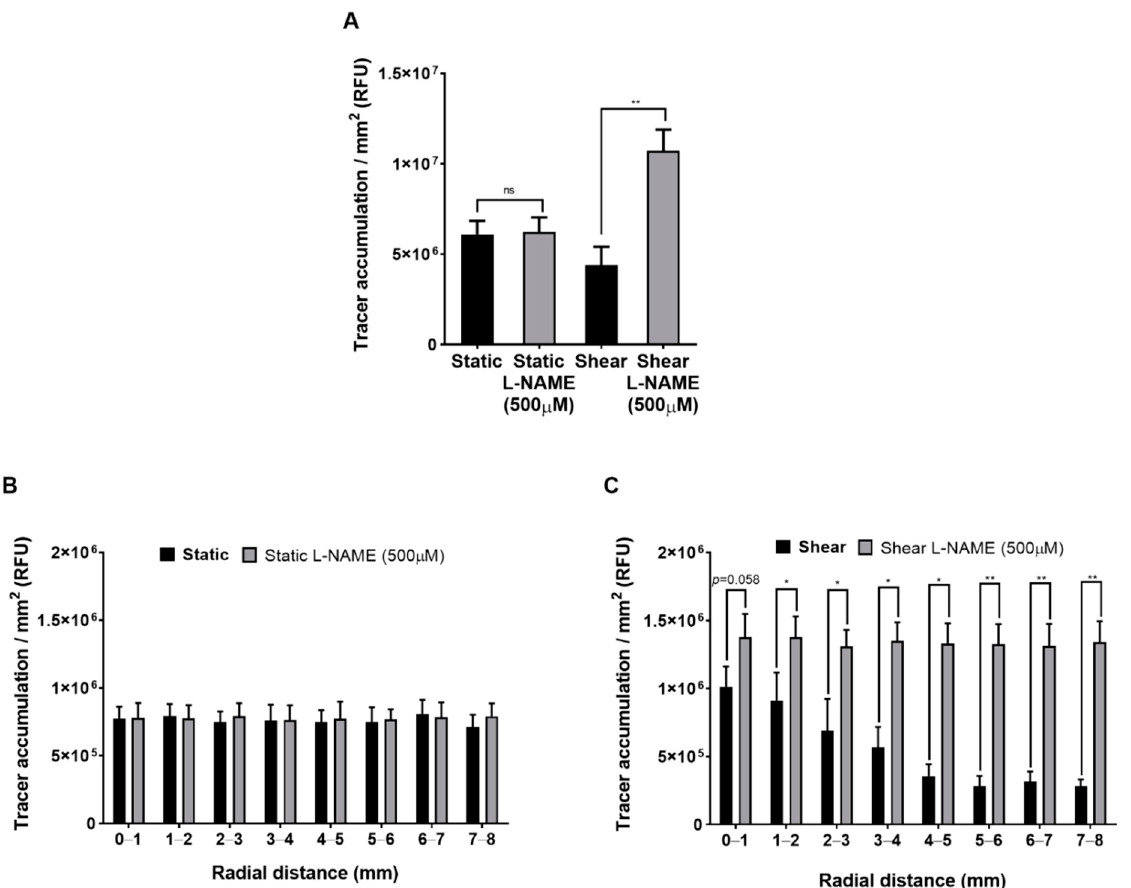
Figure 7. FITC-avidin accumulation averaged across the well for ( A ) static and sheared monolayers, with or without prior L-NAME treatment. FITC-avidin accumulation as a function of radial distance from the centre of the well for ( B ) static and ( C ) sheared monolayers, with or without prior L-NAME treatment. Mean + SEM, n = 3 isolations.